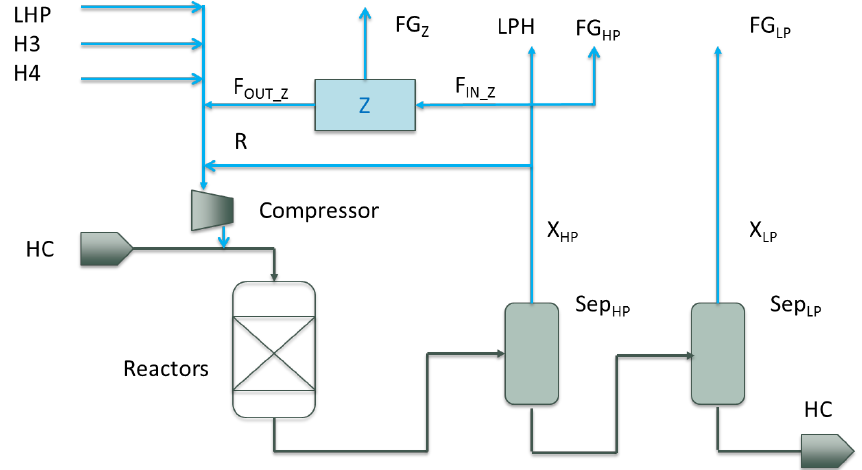
Figure 2. Simplified schematic of a typical desulphurization plant showing the hydrocarbon and hydrogen feeds, the reactor, separation units, membranes and main streams.